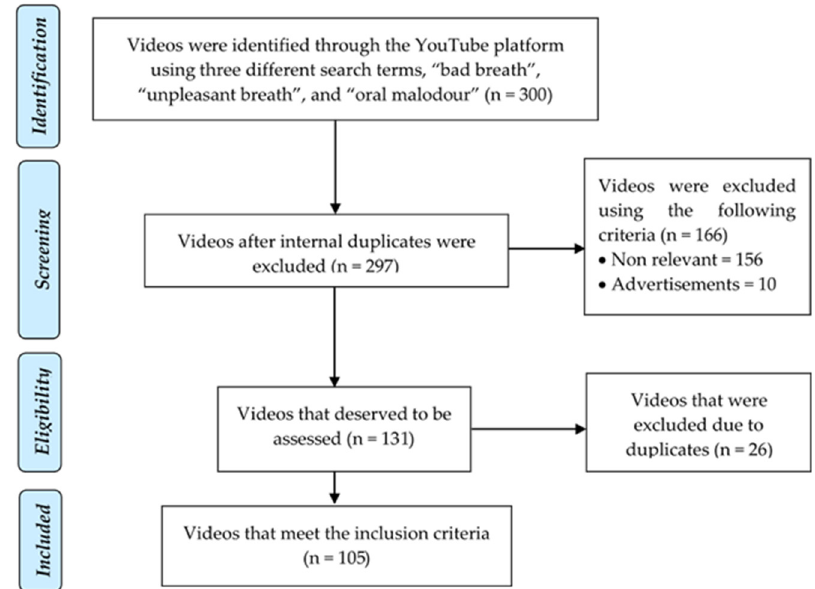
Figure 1. Selection of YouTube videos based on the PRISMA flow diagrams. Table 1. Characteristics of research videos.